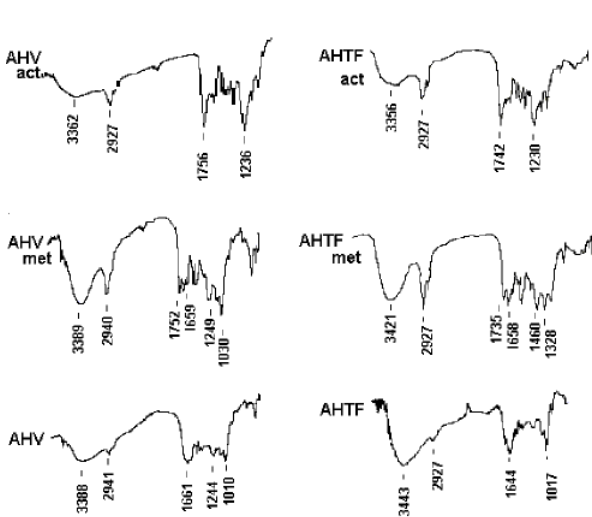
Figura 5. Espectros de infravermelho com transformada de Fourier e atribuições das regiões de absorção (número de onda, cm -1 ) para os ácidos húmicos isolados de vermicomposto (AHV) e seus derivados metilados (AHVmet) e acetilados (AHVact) e de torta de filtro (AHTF) e seus derivados metilados (AHTFmet) e acetilados (AHTFact).